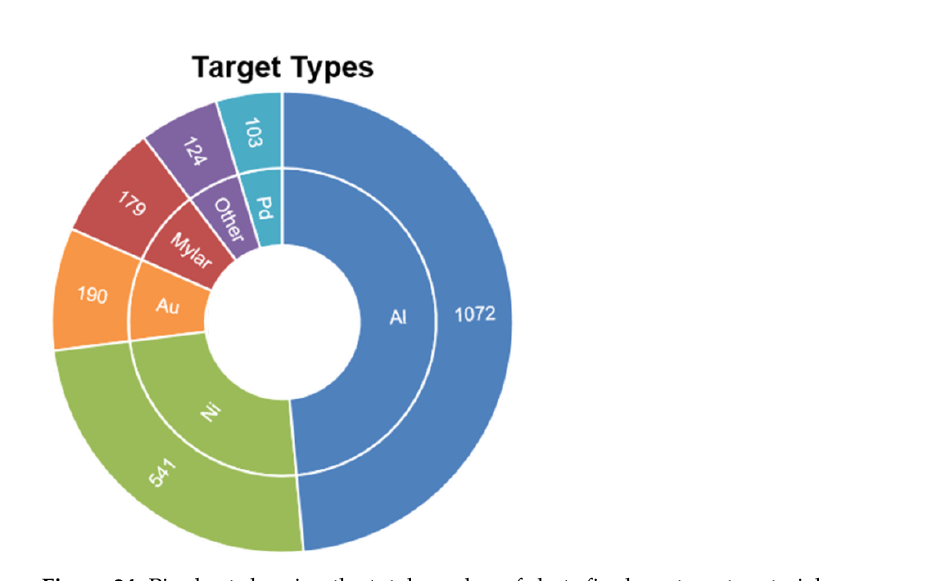
21 of 25 Figure 23. Processed data for a high repetition-rate (0.5 Hz) series of 100 shots on 12 μm aluminum target. The plot pro- vides the proton energy distributions online in terms of particle flux (color bar) and cutoff energy for each shot in the series.